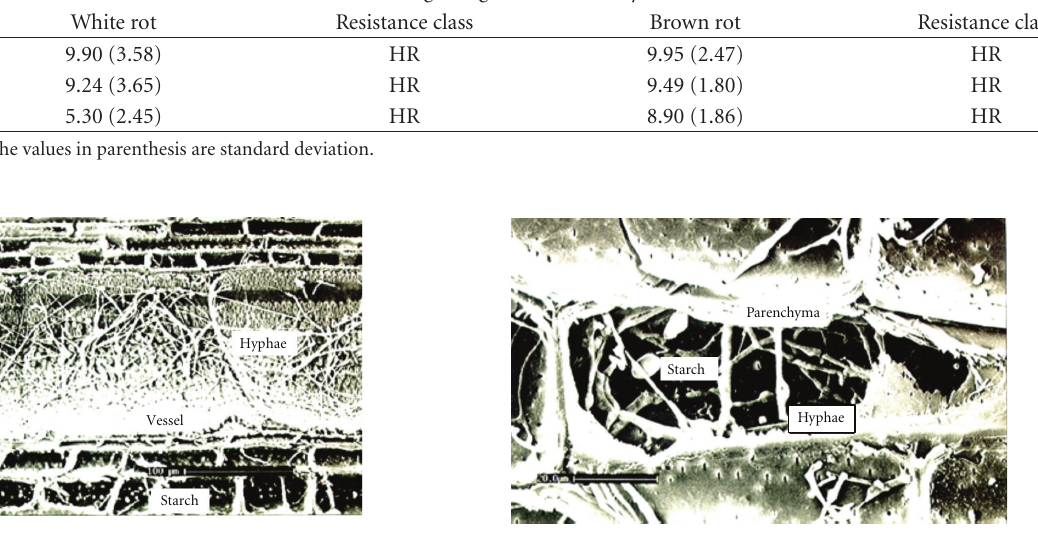
Figure 1: White rot hyphae penetration in vessel lumen (longitudi- nal section, 650x).